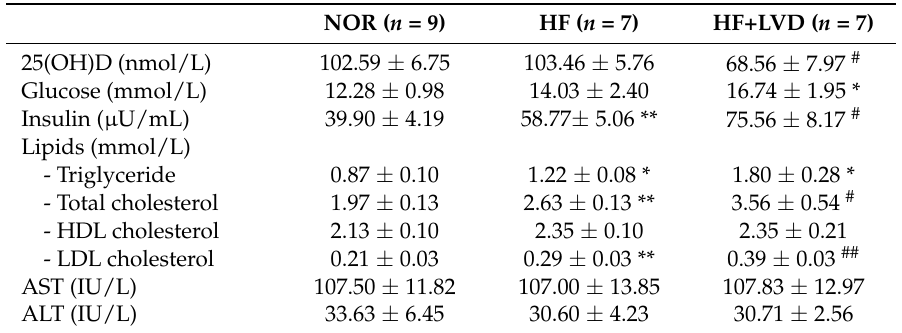
Table 4. Metabolic serum characteristics of low ‐ fat control (NOR) and high fat control (HF) and vitamin D ‐ insufficient (HF+LVD) ‐ fed rats.